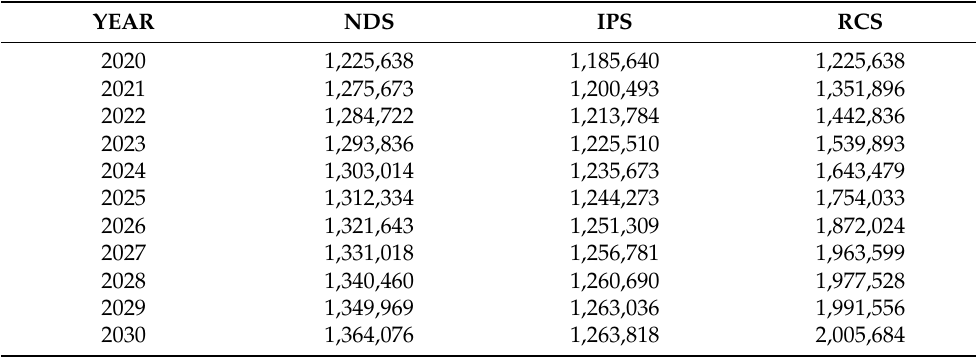
Table 2. Carbon emissions under different scenarios 2020–2030. (Unit: 10,000